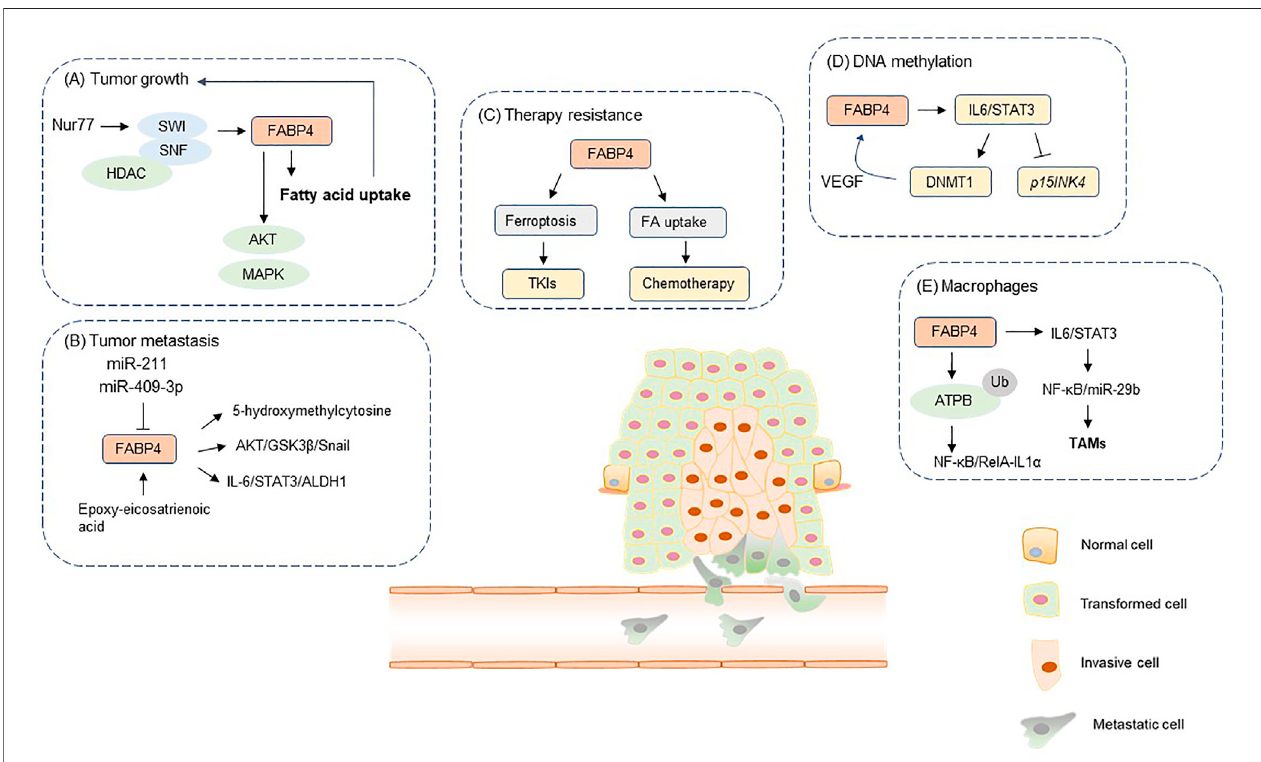
FIGURE 1 | The role of FABP4 in tumor initiation and development. FA, fatty acid; TAMs, tumor-associated macrophages; TKIs, tyrosine kinase inhibitors. FABP4 participates in the regulation of diverse tumorigenic process, including (A) tumor growth, (B) tumor metastasis, (C) therapy resistance, (D) DNA methylation, (E) interaction between tumor cells and